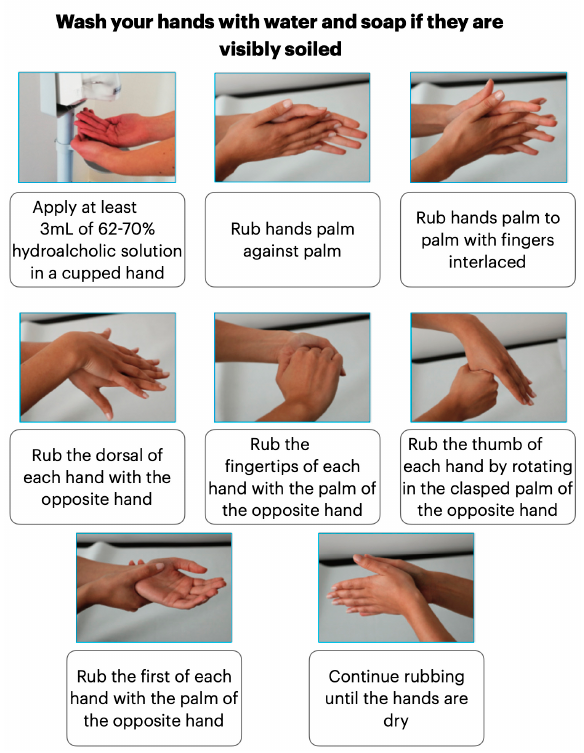
Figure 2. Hands sanitization with hydroalcoholic solution.